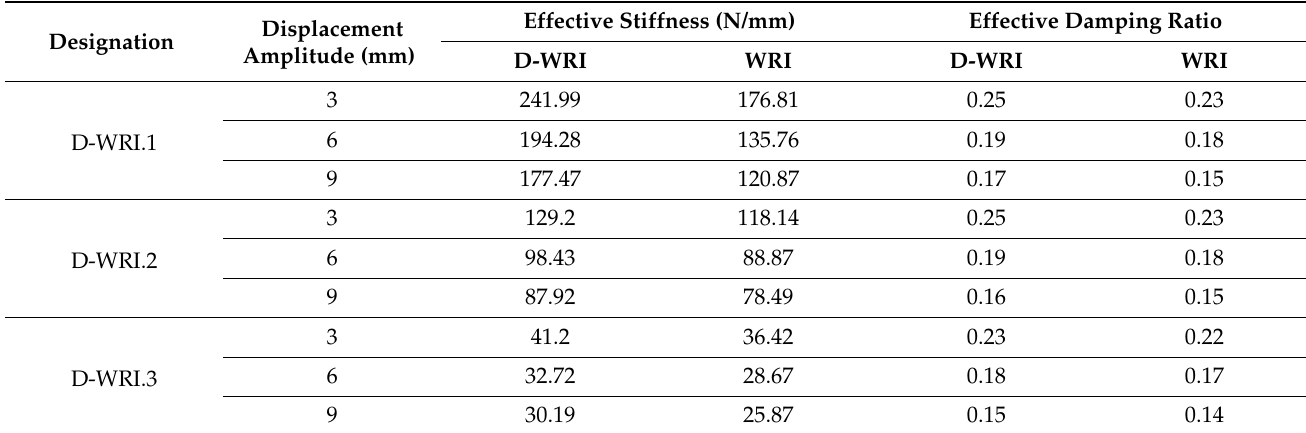
Table 8. Effective stiffness and effective damping in the roll